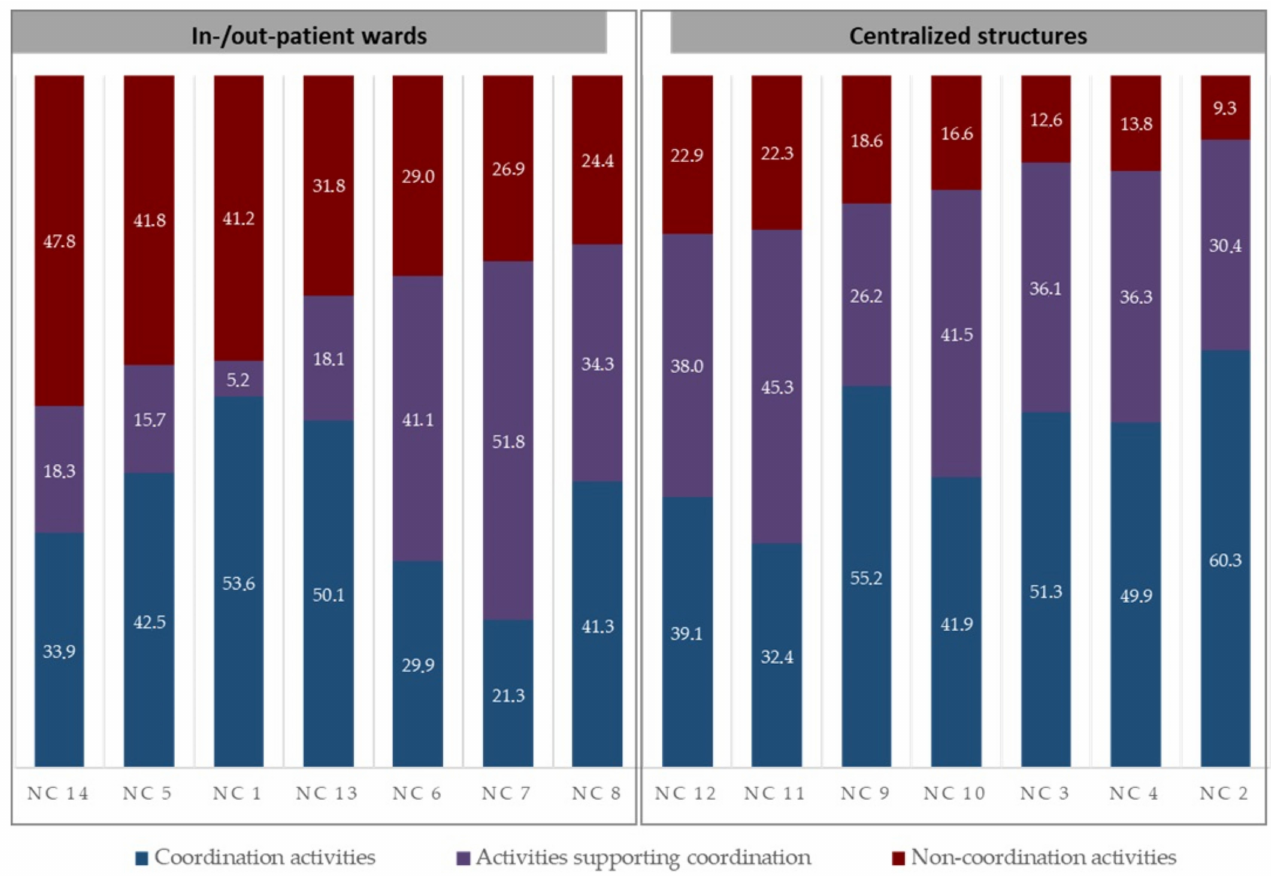
Figure 2. Comparative analysis of NC work content using the APANCO